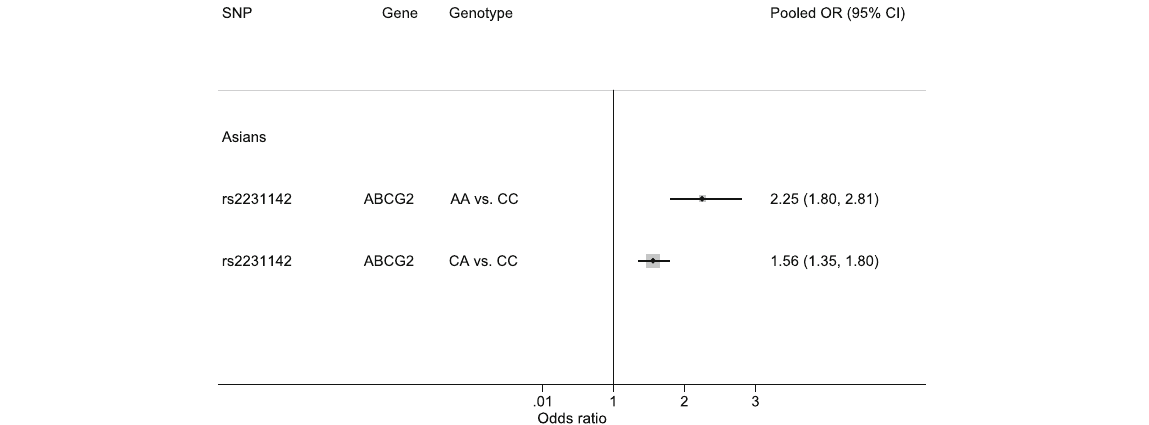
Fig. 3 Summary of pooled genotype risk effects on hyperuricemia. ABCG2 , ATP-binding cassette sub-family G member 2; CI, confidence interval; OR, odds ratio; SNP, single nucleotide polymorphism